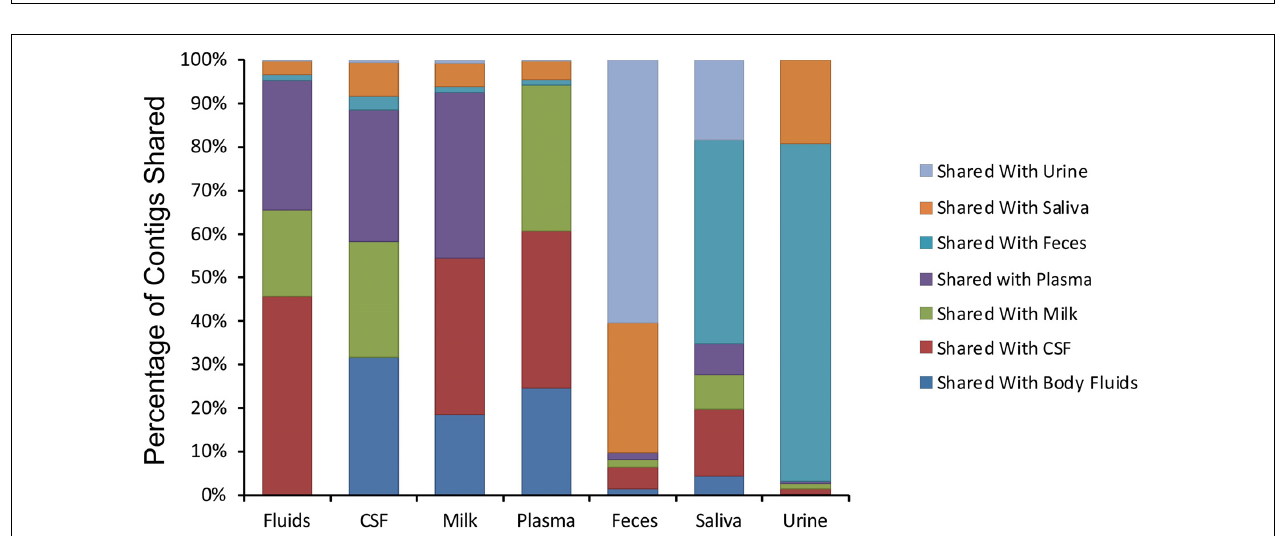
FIGURE 3 | Homologous Virus Diversity Index rarefactions based on the Chao1 Index of viral communities from various specimen types. The x-axis represents the number of virome reads sampled, and the y-axis represents virus abundance.